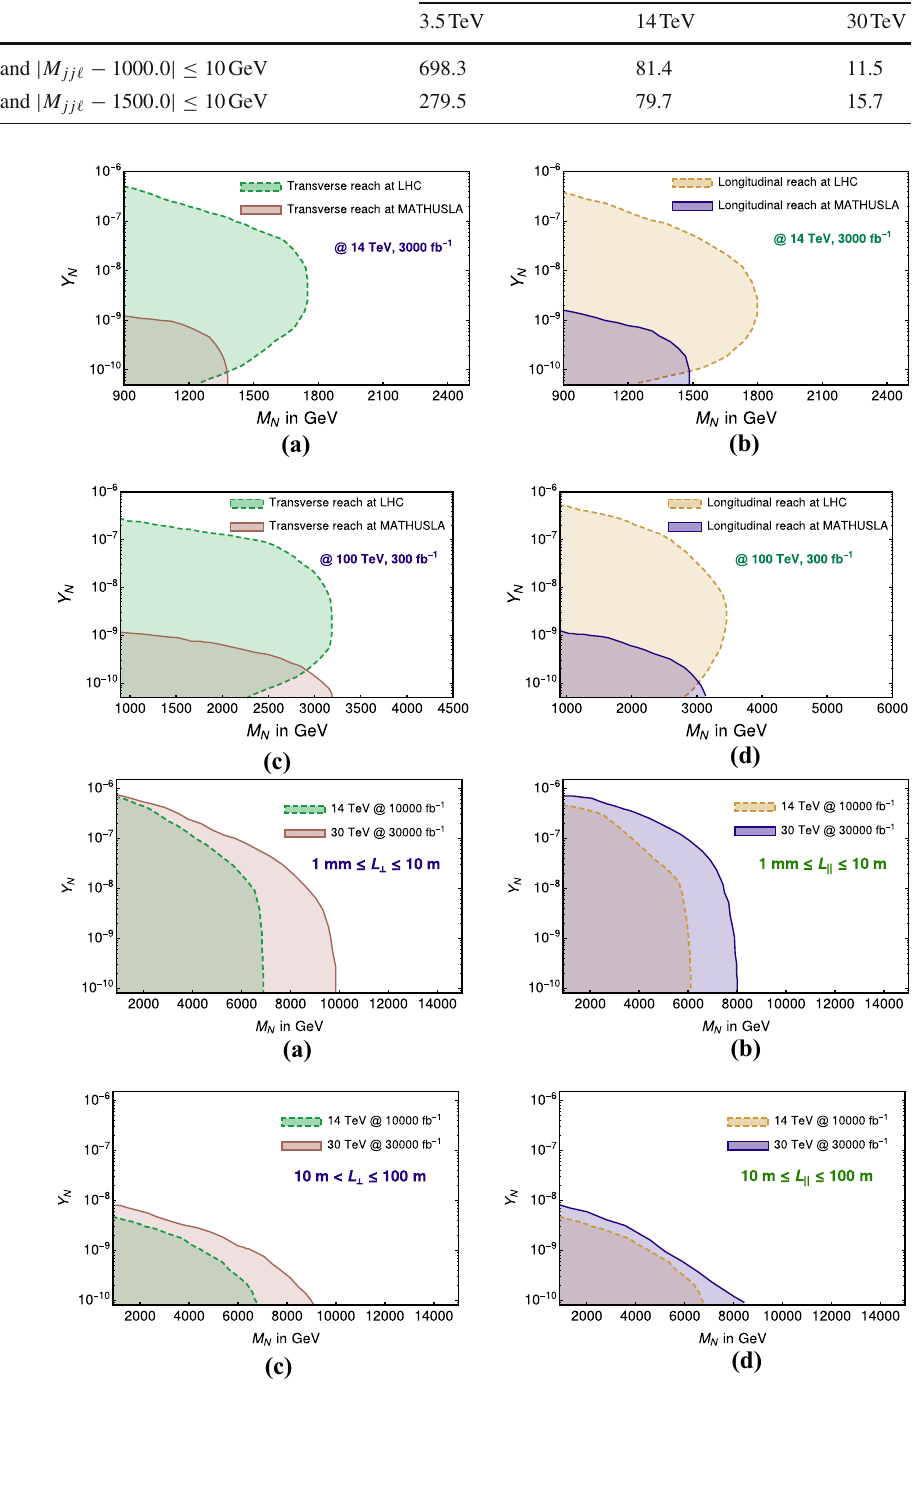
Fig. 28 Limits obtained for Yukawa coupling versus Type-III fermion mass via transverse ( a , c ) and longitudinal ( b , d ) decay lengths for the finalstates containing at least one displaced Higgs boson with the centre of mass energies of 14 and 30 TeV at the muon collider with integrated luminosities of 10,000 and 30,000 fb − 1 , respectively. a , b Represent 1 mm ≤ L ⊥ , (cid:12) ≤ 10 m and c , d depict 10 m ≤ L ⊥ , (cid:12) ≤ 100 m